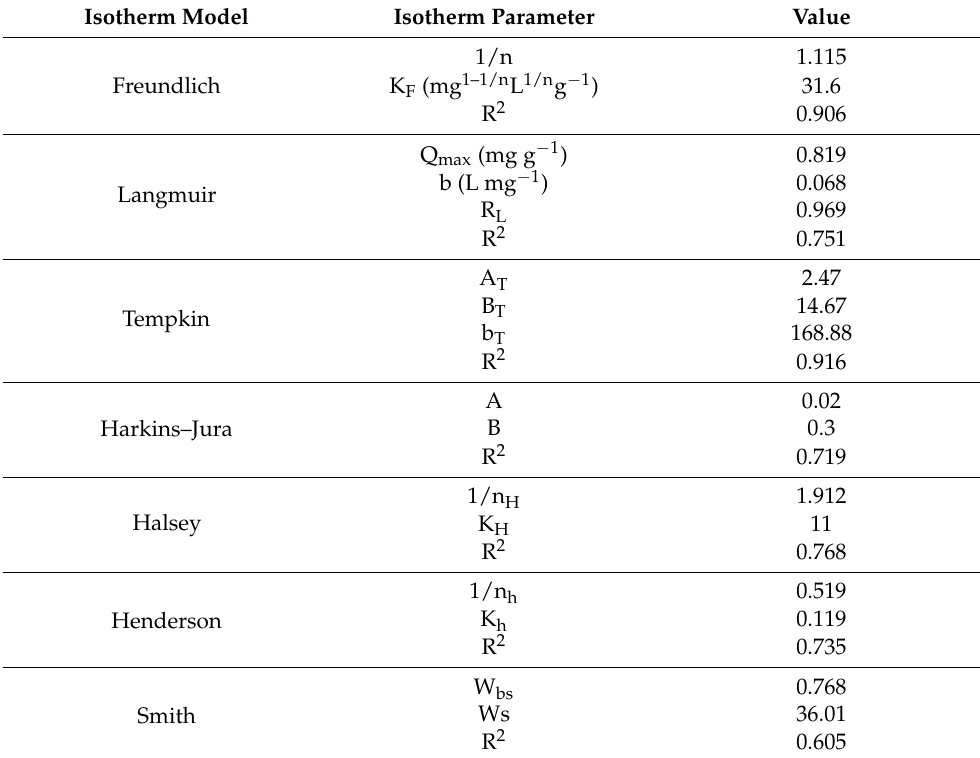
Figure 10. Linear Freundlich isotherm for MBD sorption. Table 2. Factors of isotherm models from non-linear and linear solvation.